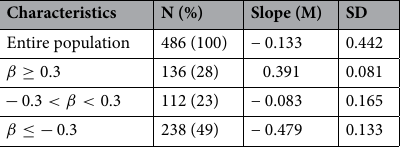
Table 3. Categorization of BFS trend patterns (N = 486).